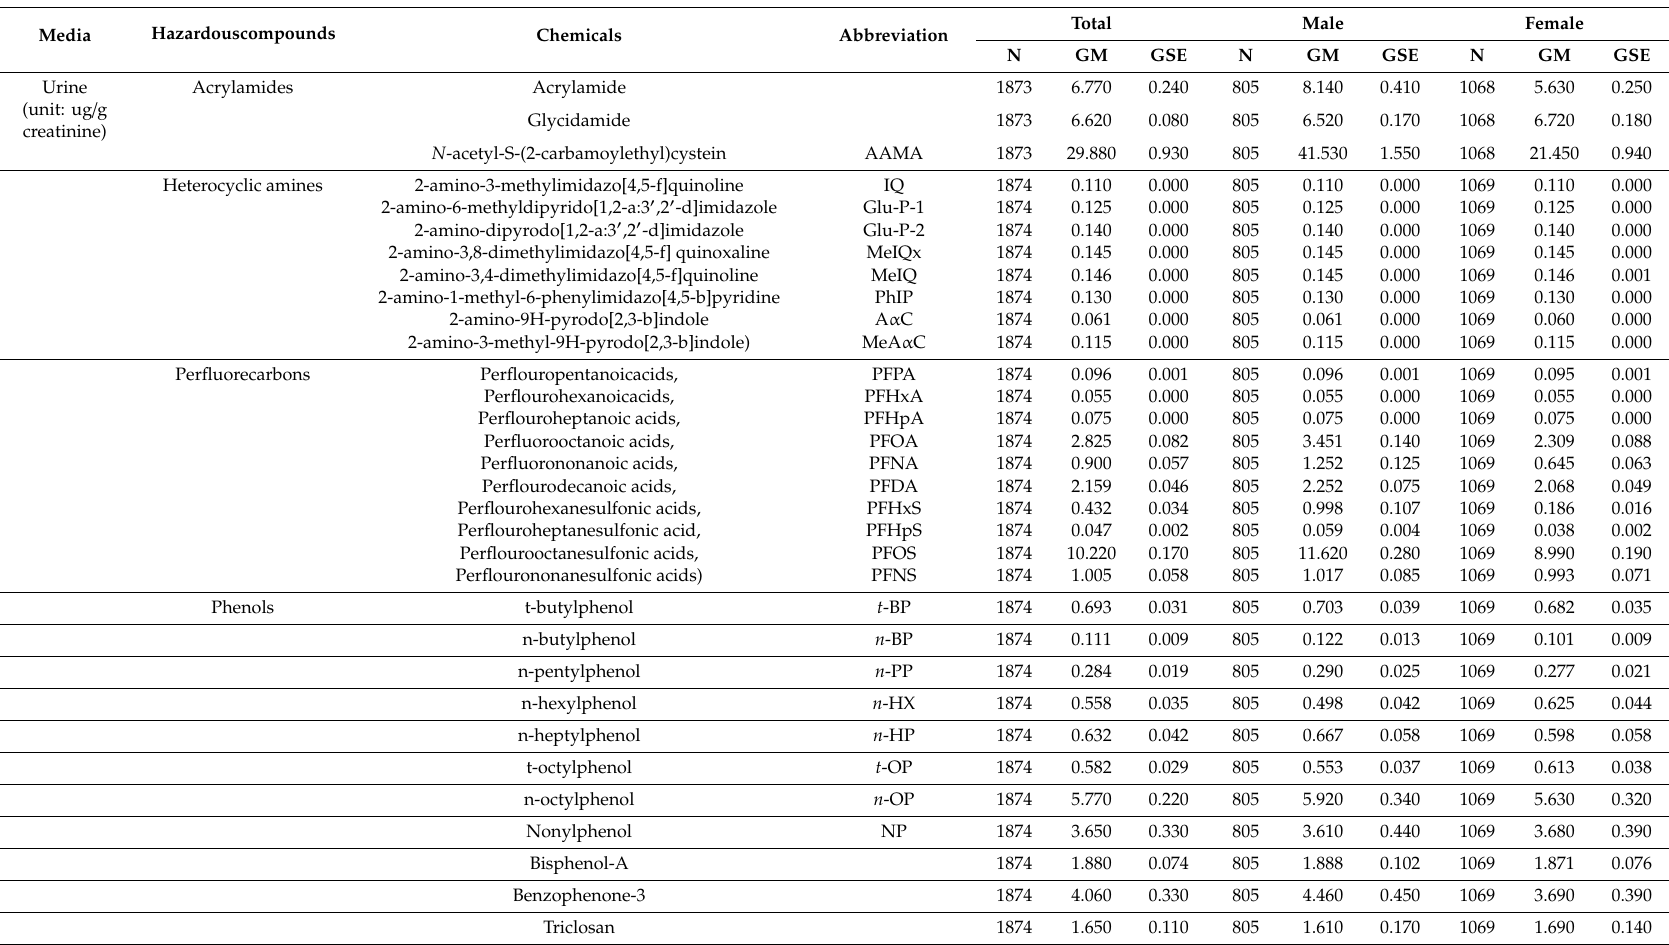
Table 4. Results of biomonitoring data for hazardous compounds and chemicals (N =